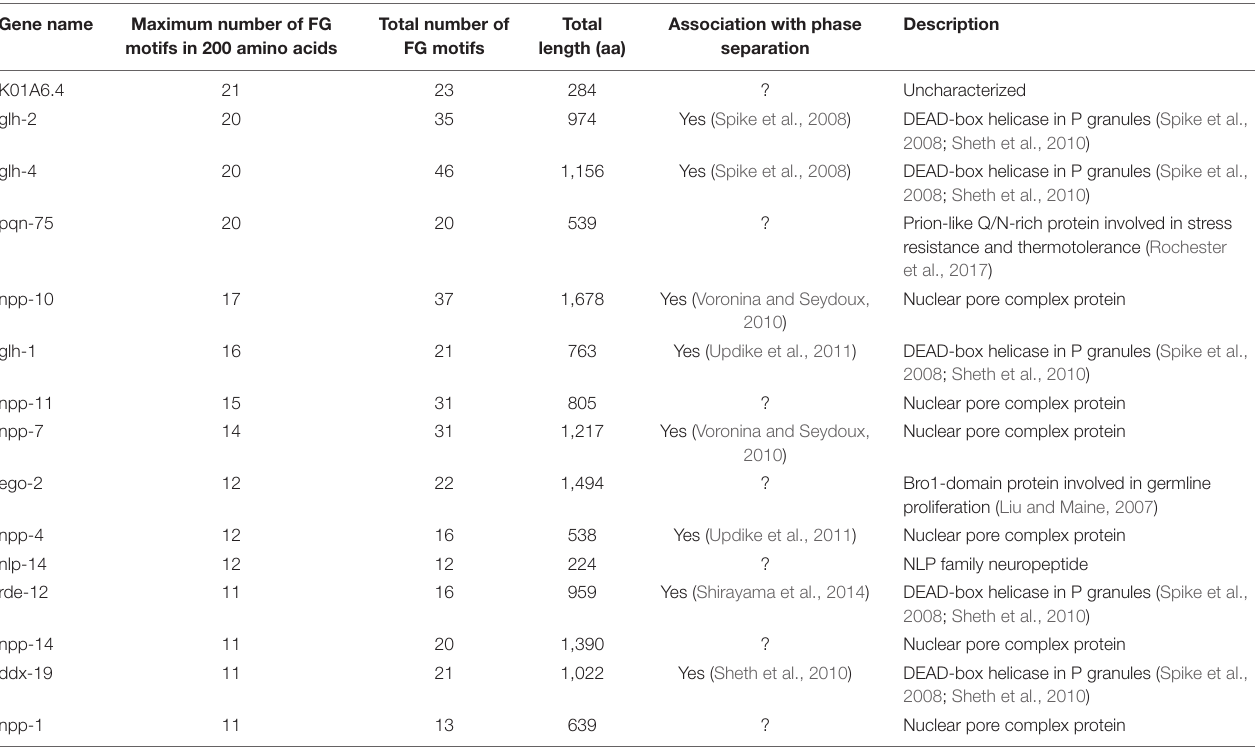
TABLE 1 | The top 15 phenylalanine-glycine (FG)-rich proteins in C. elegans